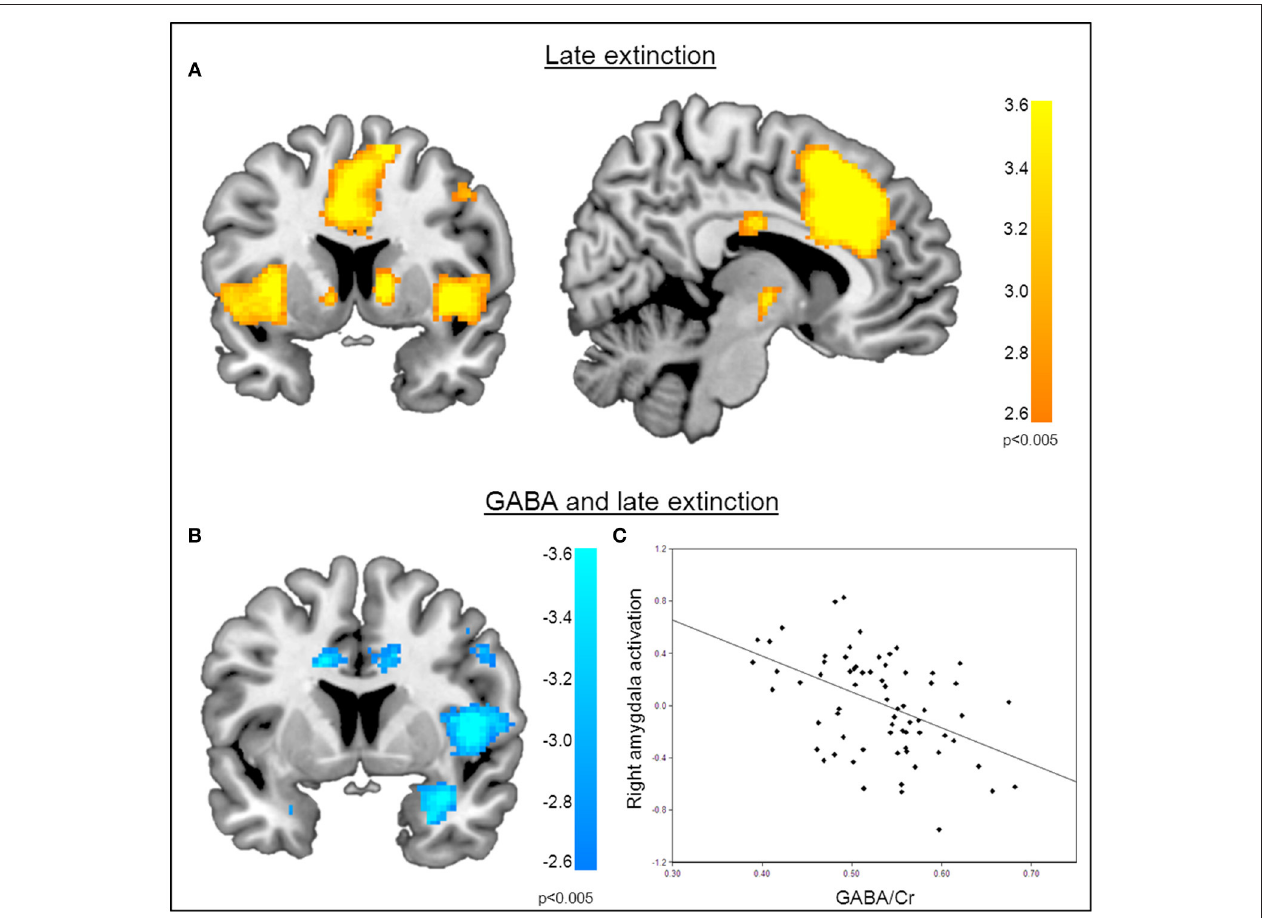
FIGURE 4 | Correlation of GABA levels and BOLD activity during late extinction. (A) Increased BOLD activity in the dACC, the insula, and the superior medial gyrus for the “CS + > CS − ” contrast during the late phase of extinction. (B) GABA mediated deactivation of the right amygdala (MNI x,y,z = 28, 4, − 28; P SVC < 0.05), right insula (MNI x,y,z = 48, 8, 6; P FWE = 0.008), and middle cingulate gyrus (MNI x,y,z = 16, − 22, 34; P FWE < 0.001) during the late phase of extinction learning, indicating that high GABA levels are associated with diminished activation of the right amygdala. For displaying purpose, the image threshold is set to p = 0.005, uncorrected. (C) Correlation plot of GABA levels and activation extracted from the right amygdala during late extinction for illustration purposes, suggesting that high GABA levels facilitate extinction learning while low GABA levels hamper extinction